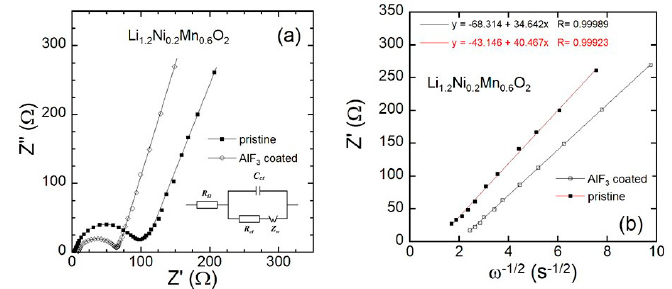
( b ) plots of Z’ vs. ω − 1 / 2 . Solid lines are the fits using the equivalent circuit shown as